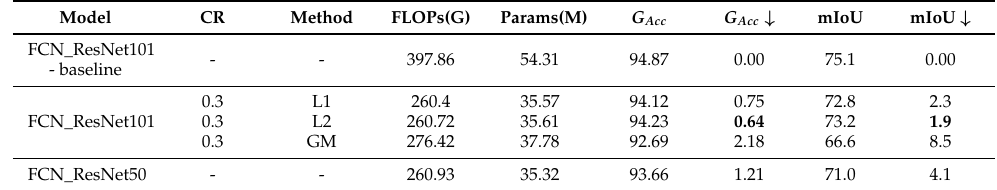
Table 3. Comparison results of pruning FCN on Pascal VOC. “ G Acc ” indicates global accuracy; “ G Acc ↓ ” and “mIoU ↓ ” are dropped from the baseline model, with smaller values being better; “CR” and “Method” have the same meaning as in Table